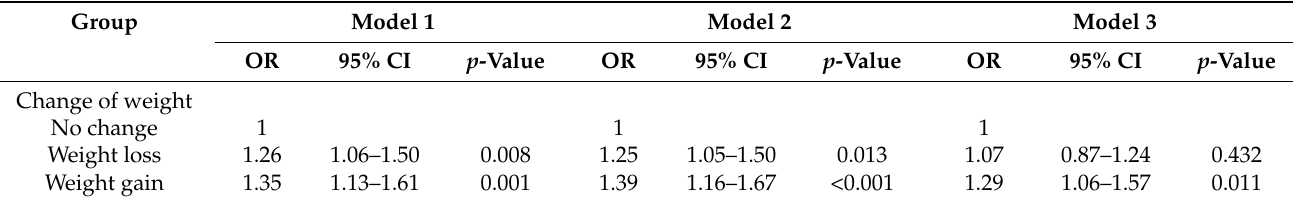
Table 2. Association between change of weight and low back pain using multiple logistic regression.